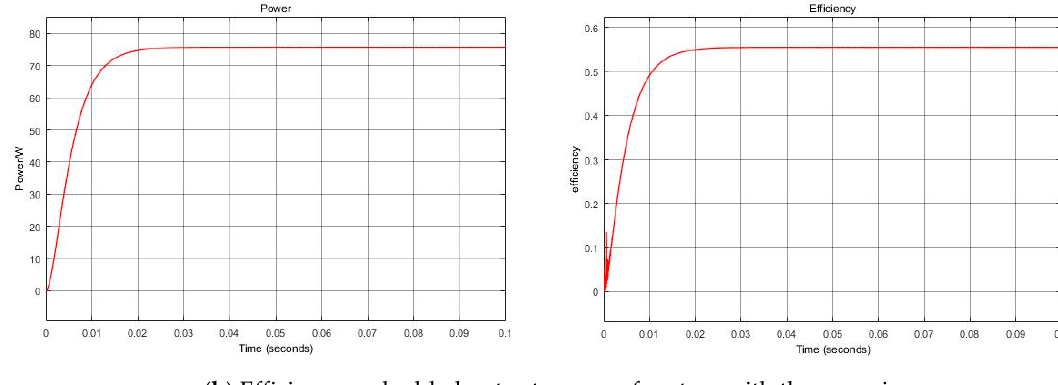
Figure 4. Output power and efficiency of the two systems.